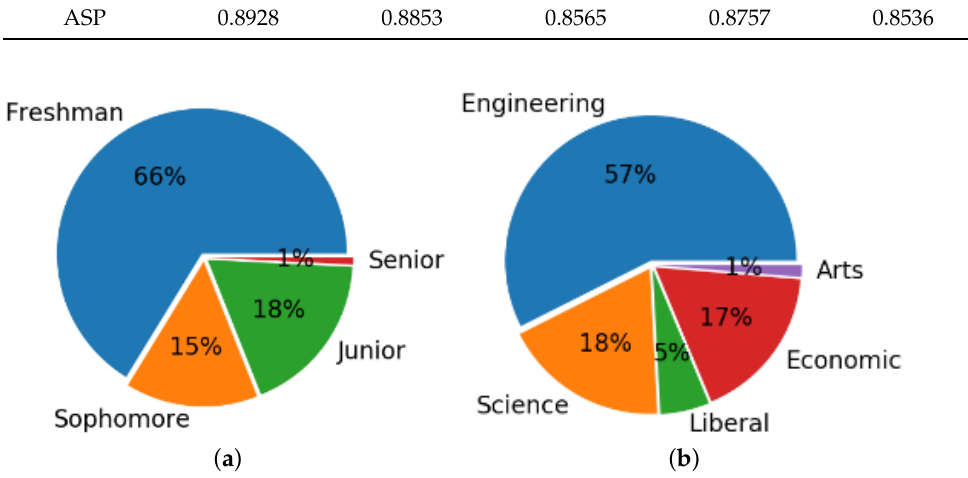
Figure 3. Student distribution. ( a ) Student grade distribution. ( b ) Student major